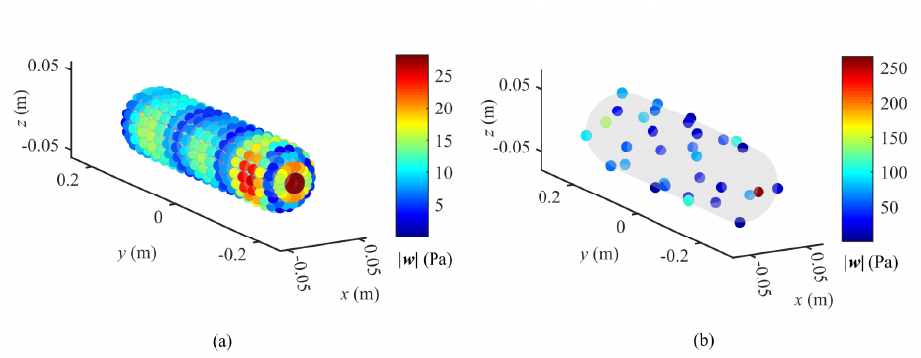
Figure 12. The position and the strength of the equivalent source at 5000 Hz: ( a ) uniform distribution and ( b ) optimum distribution.